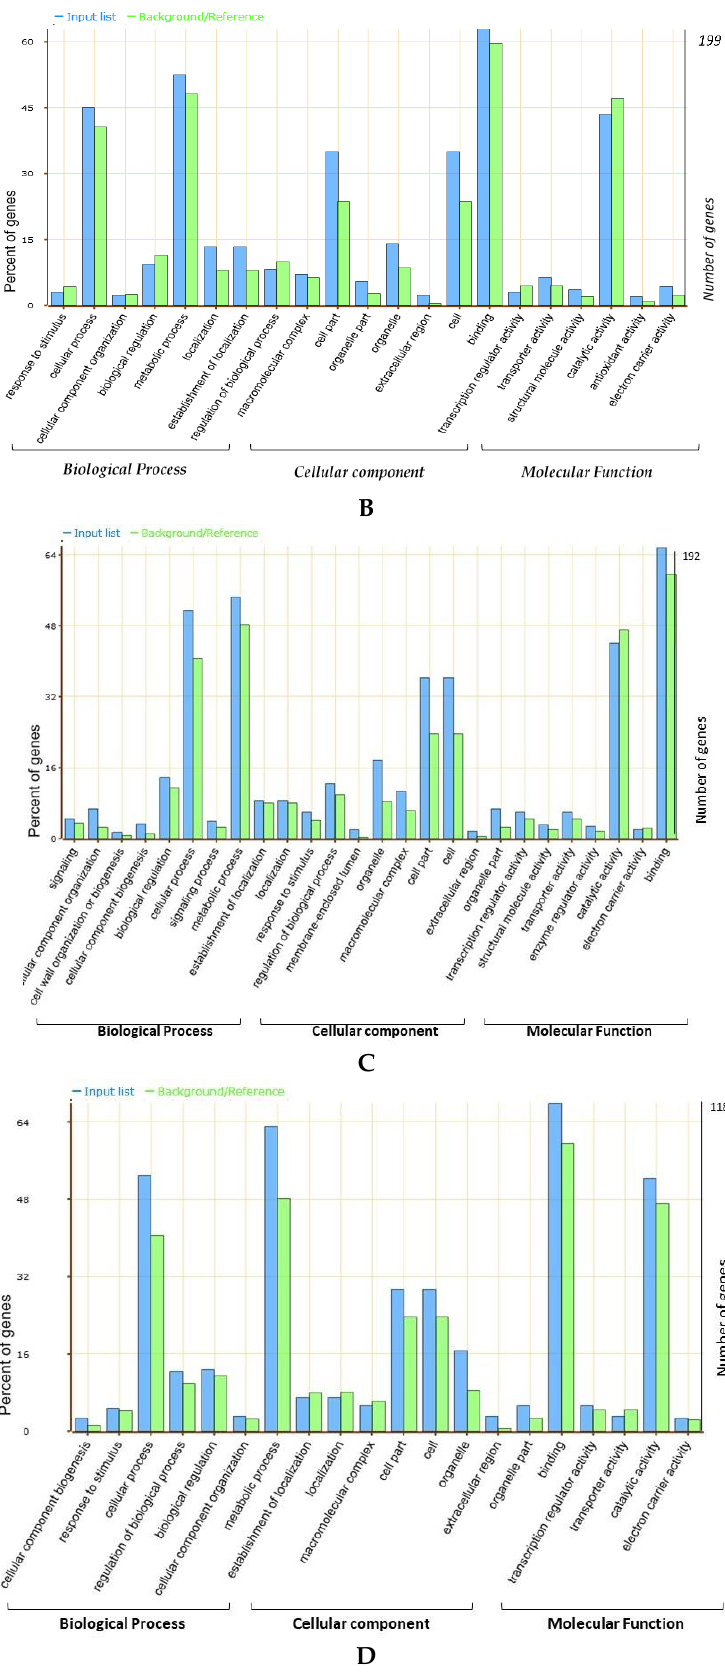
Figure 4. agriGO annotation information. (A) Cluster-06 (QTL Hotspot A), (B) Cluster-10 (QTL Hotspot B), (C) Cluster-13 (QTL Hotspot C), and (D) Cluster-20 (QTL Hotspot D).